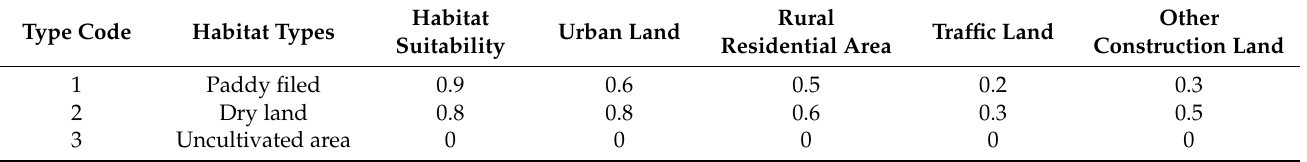
Table 4. Different cultivated land habitat types and their sensitivity to threat factors.